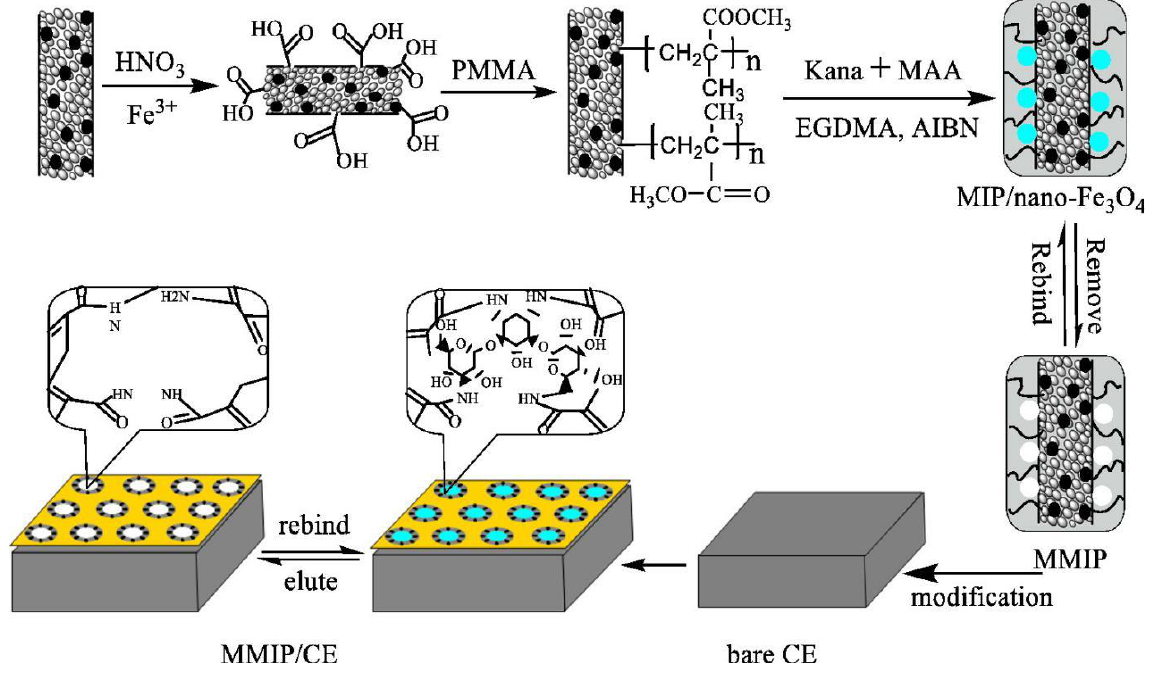
Figure 5. Schematic illustration of the magnetic imprinted electrochemical sensor. Adapted with permission from Ref [75] . Copyright 2015, Elsevier.